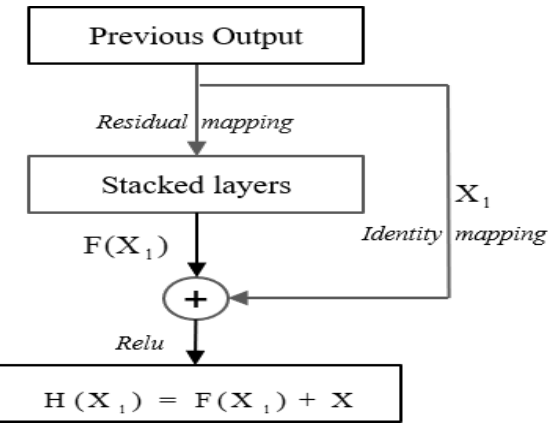
Figure 4. Residual learning